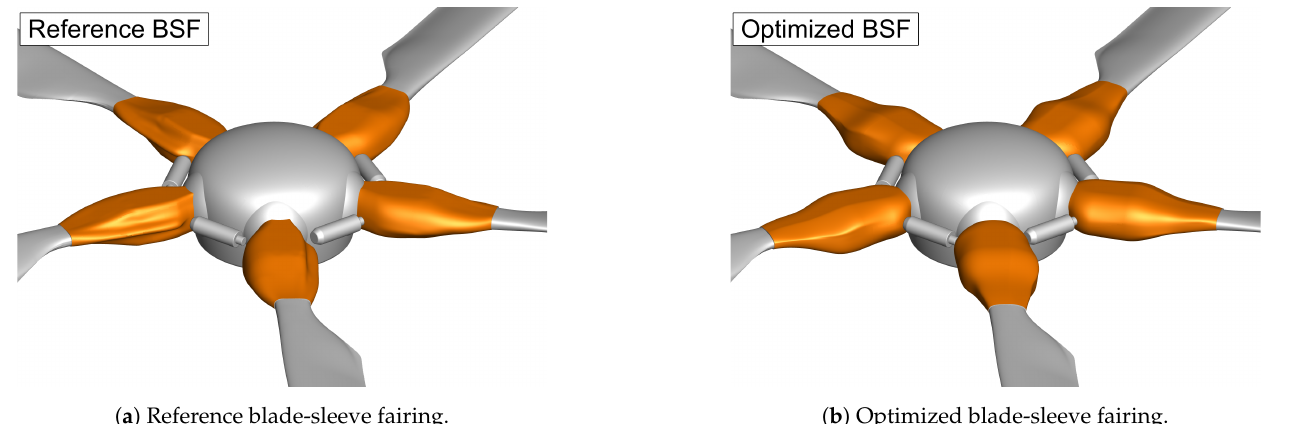
Figure 12. Shape comparison between the reference blade-sleeve fairing and the optimized blade-sleeve fairing obtained within the FURADO